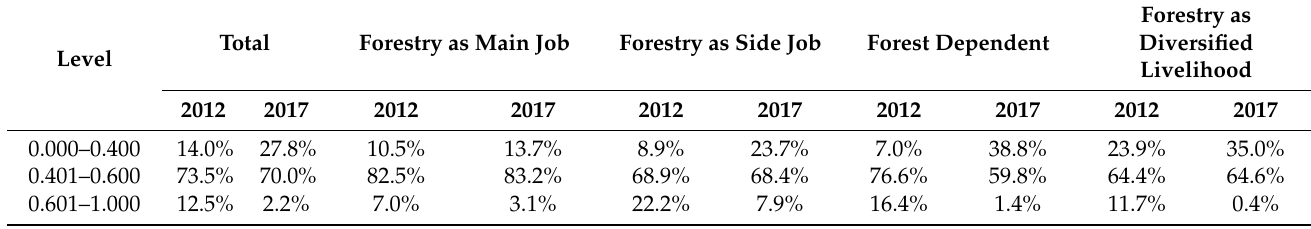
Table 6. Internal distribution of